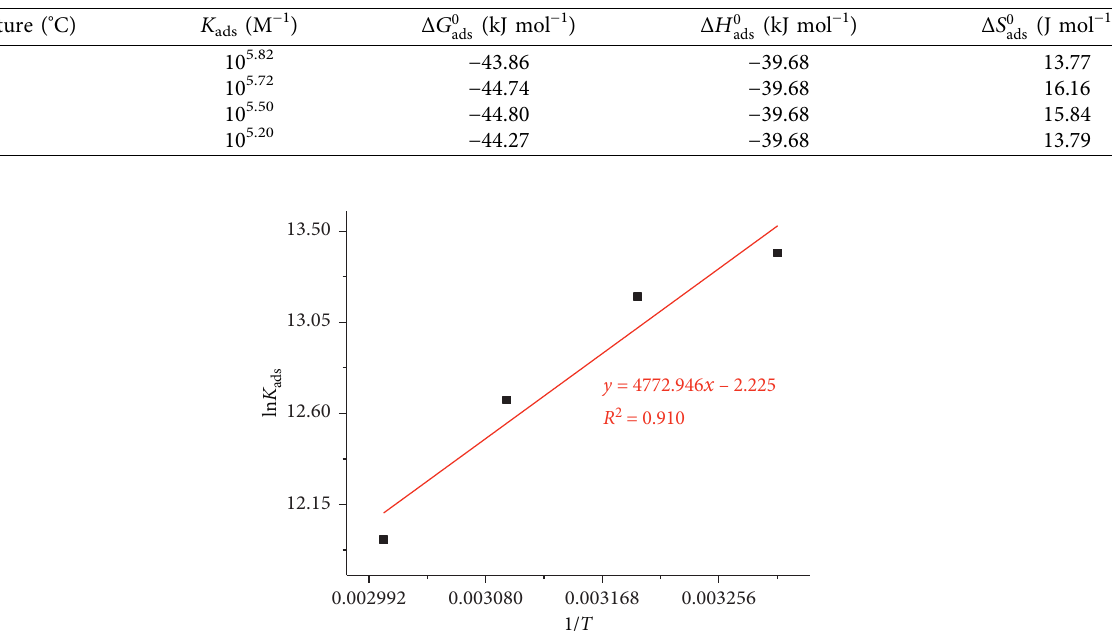
Figure 11: Langmuir’s adsorption isotherm of BPTU on the steel surface in 1.0M HCl. Table 4: Adsorption parameters of BPTU in HCl solution.